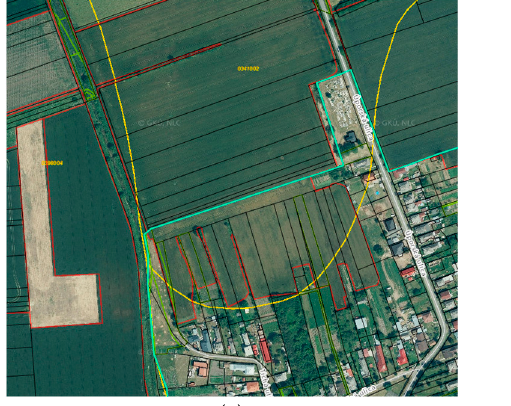
Figure 17. Illustration of differences in the registration of EPEU areas in the cadastral unit after LC registration into the real estate cadastre: ( a ) Agro layer of ZBGIS; ( b ) from the real estate cadastre.